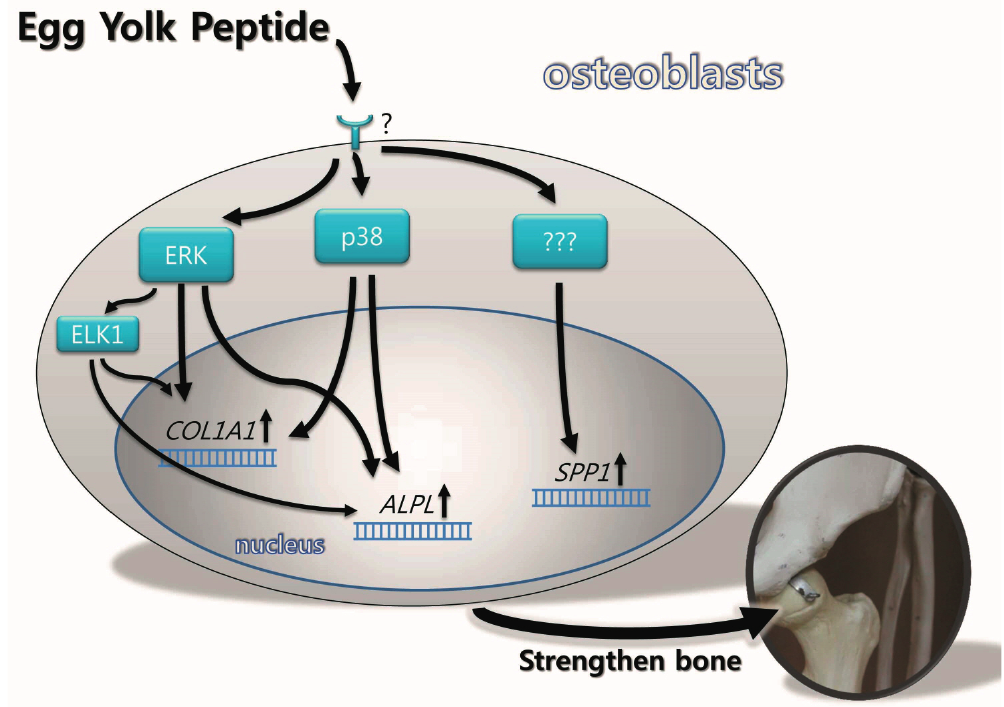
Figure 8. Schematic summary of the possible molecular mechanisms by which YPEP regulates the expression levels of COL1A1, ALPL, and